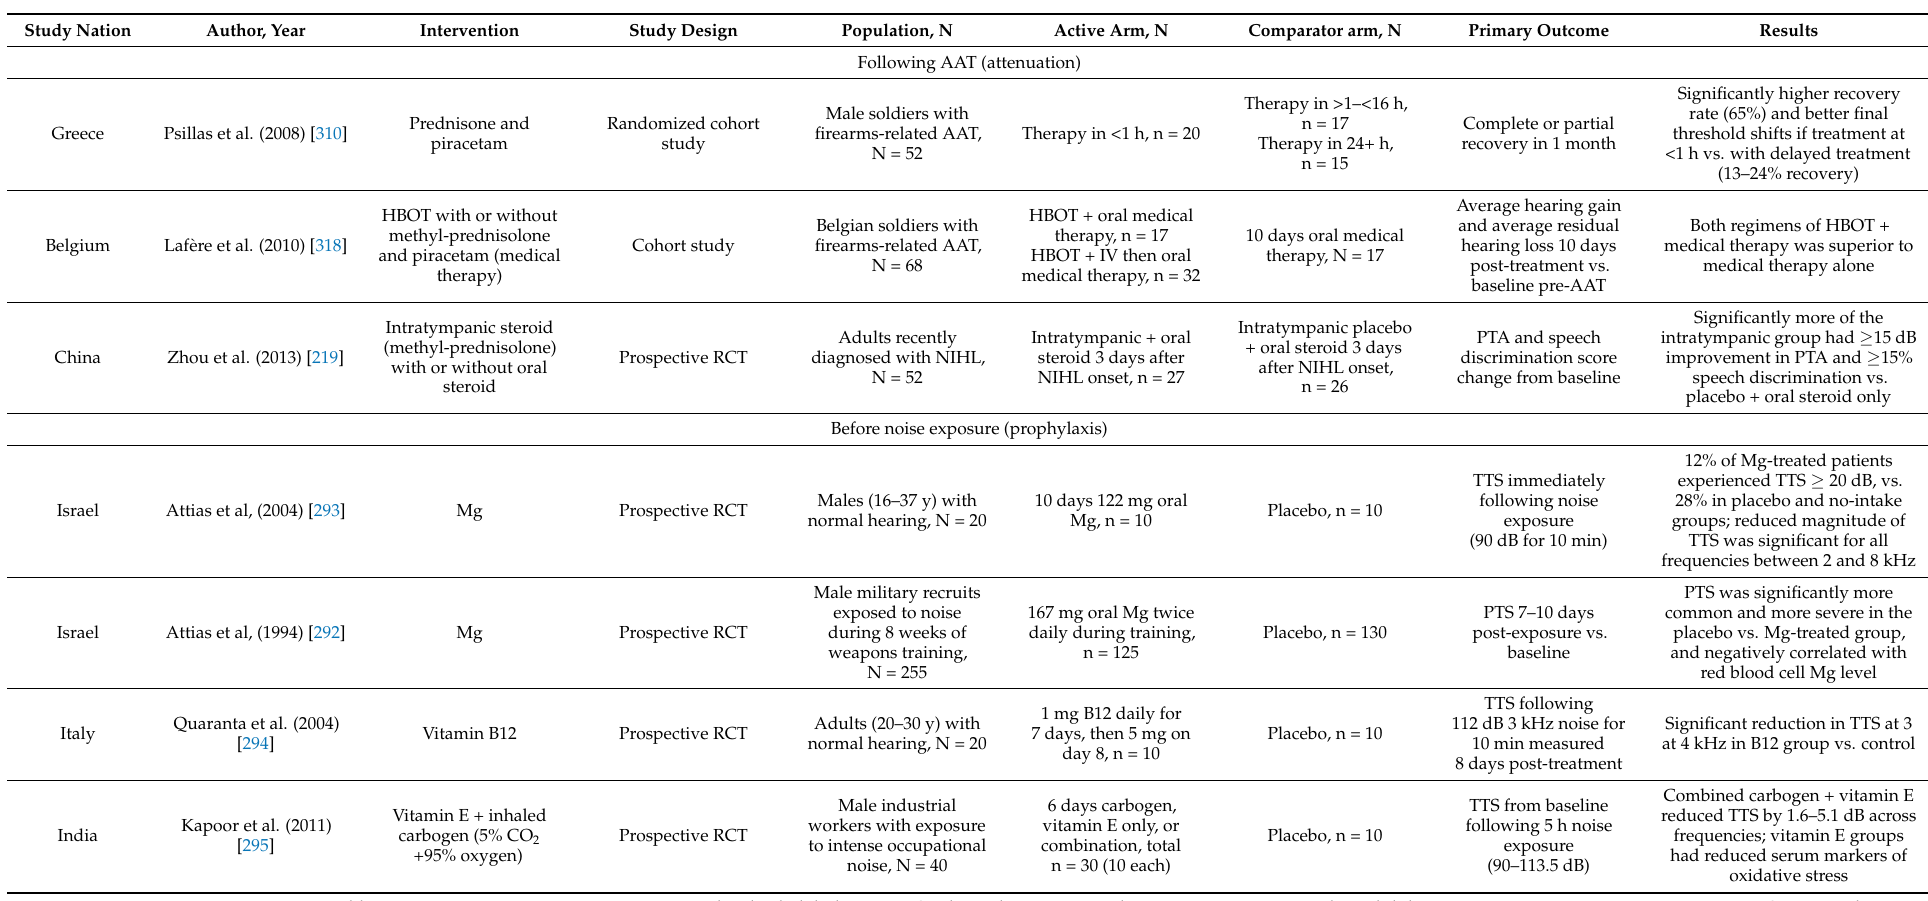
Table 3. Additional studies of therapies to prevent or attenuate NIHL (conducted outside of the